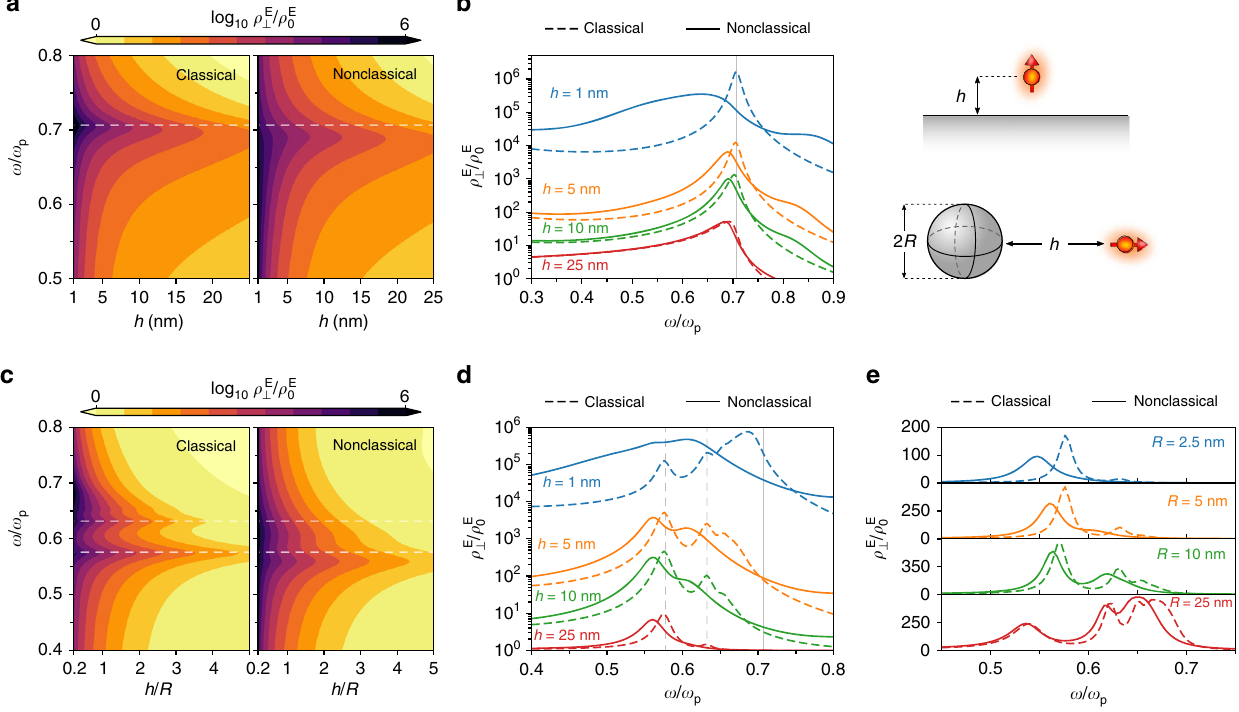
, of a normally-oriented emitter near a – b a planar metal surface 0 ffiffiffi p = 2 . c Normalized LDOS near an R ¼ 5nm jellium sphere ffiffiffiffiffiffiffiffiffiffiffiffiffiffiffiffiffiffiffiffiffiffiffiffi p p 1 þ ð l þ 1 Þ = l for l 2 f 1 ; 2 g .